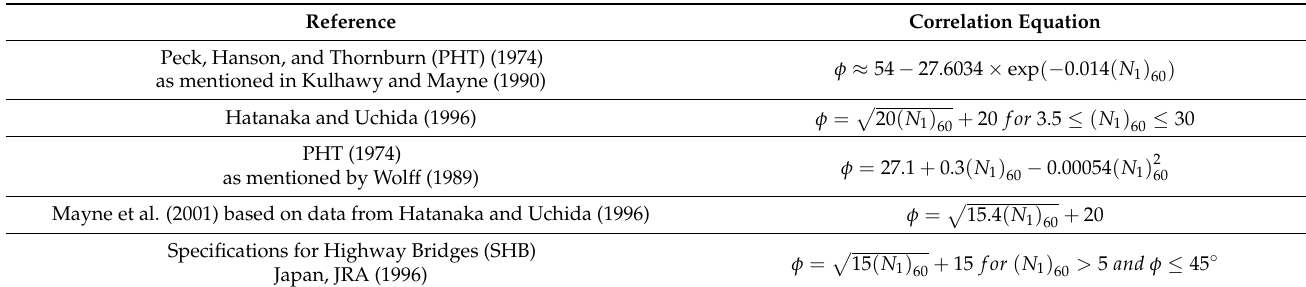
Table 6. Summary of equations correlating the friction angle to the corrected standard penetration test (SPT)-N value [31]. Reference Correlation Equation Peck, Hanson, and Thornburn (PHT) (1974) as mentioned in Kulhawy and Mayne